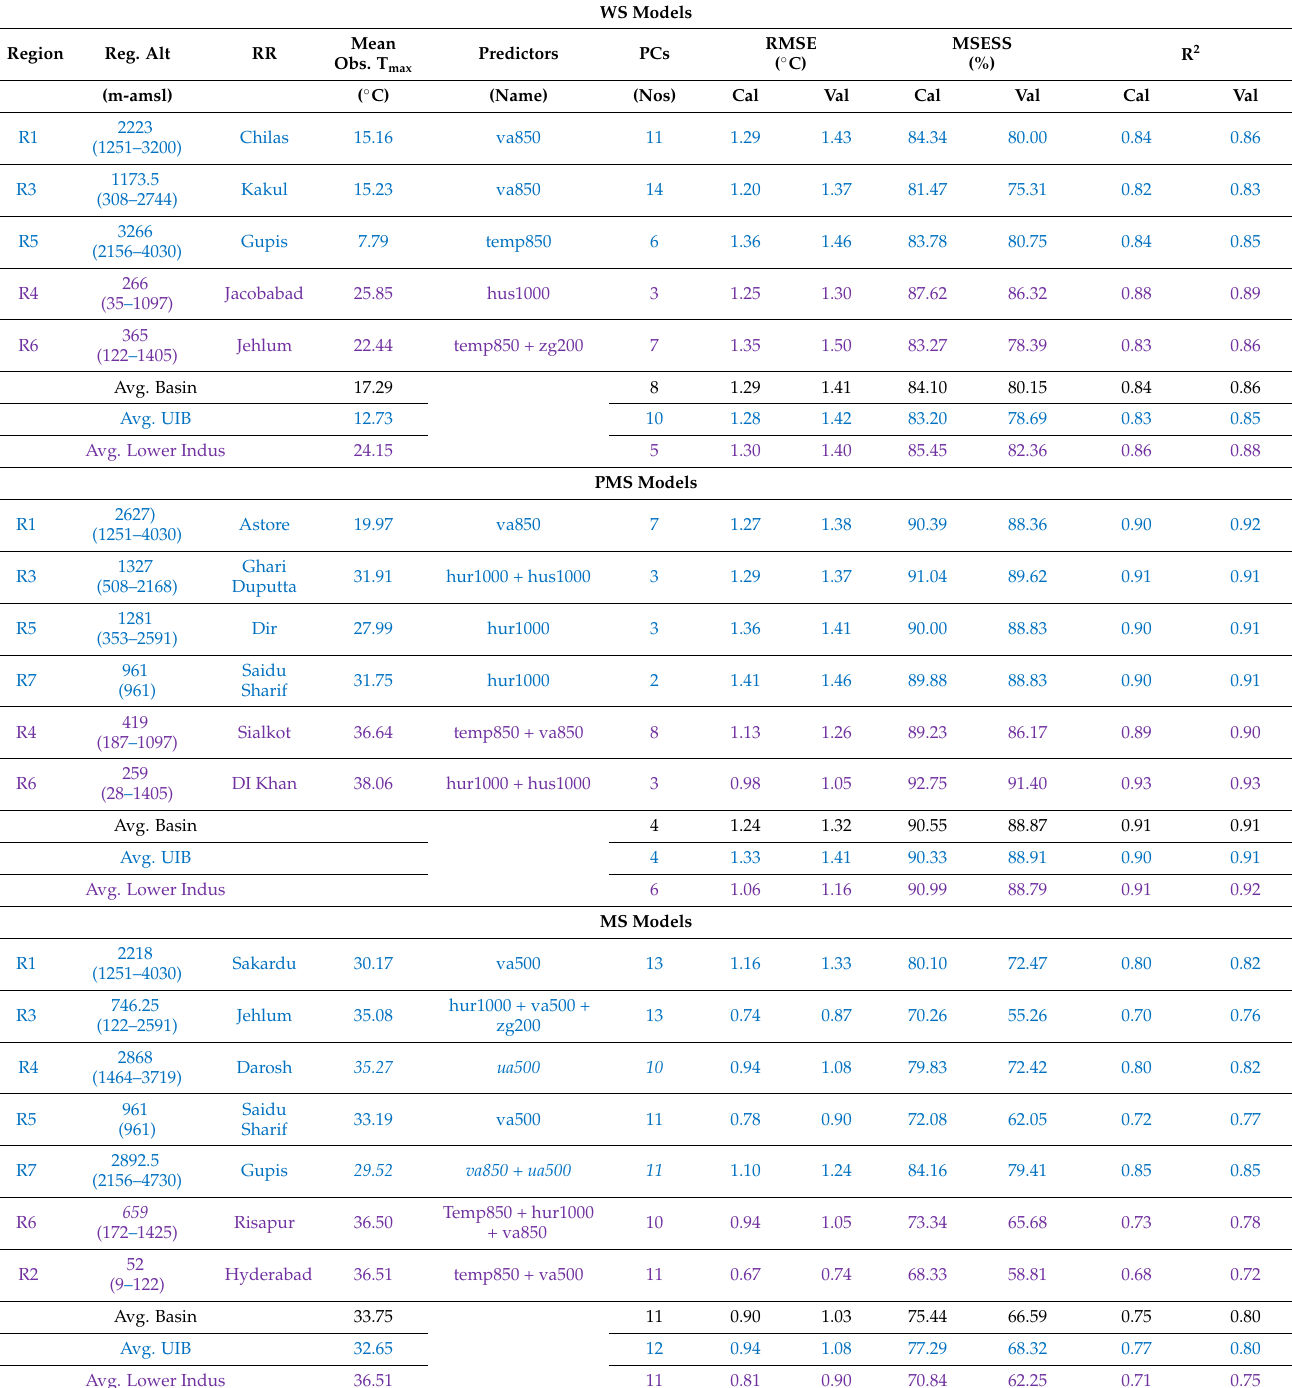
Table 2. Information about the identified sub-regions, regionally representative stations (RR), governing predictors, and the T max downscaling models’ statistical performance during all three seasons under the basin-wide regionalization experiment. The blue (violet) and black colors differentiate among the UIB (Lower Indus) regions and the entire basin. In the table, Reg. Alt is the altitudinal range (elevations in m above mean sea level) for a given region, Mean Obs. Temp indicates the mean observed T max at RR. Predictors (PCs) show the explaining variables (number of PCs). RMSE, MSESS, and R 2 are the root mean square errors, mean squared error skill scores, and coefficient of determination during the calibration (Cal) and validation (Val) periods, respectively. Additionally shown are the average statistical performances over the UIB (Avg. UIB), Lower Indus (Avg. Lower Indus), and across the entire basin (Avg.